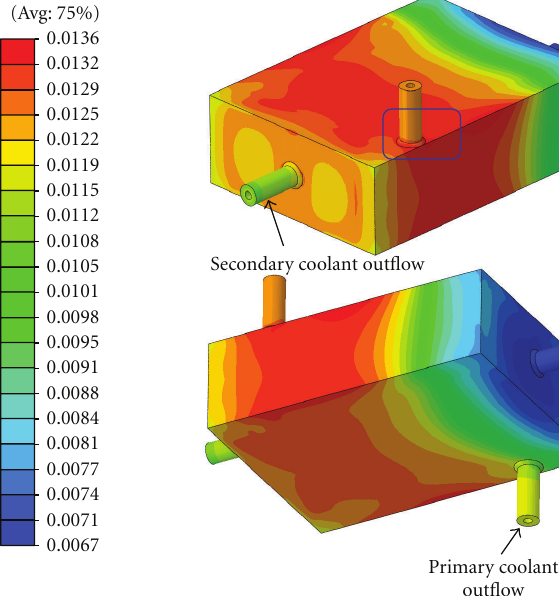
Figure 15: Strain contour in case of imposing a suggested boundary condition.